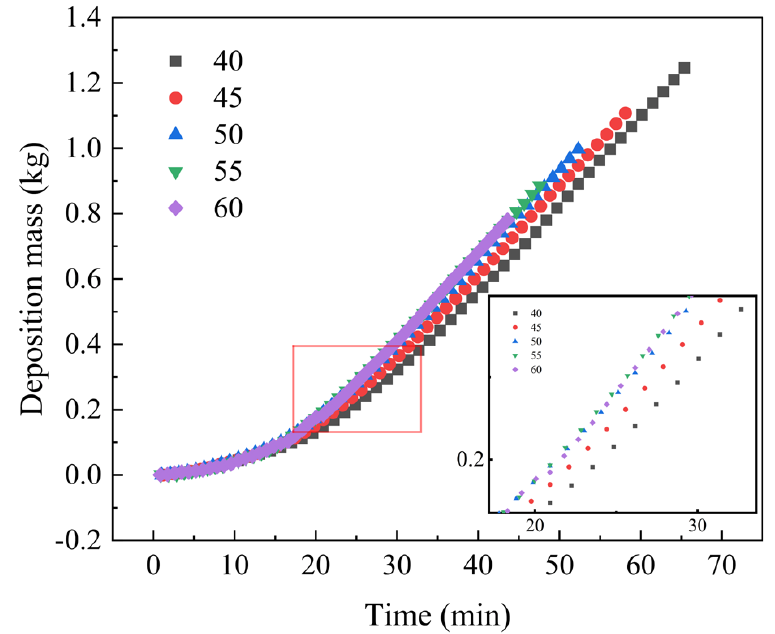
Figure 4. The relationship between deposition mass and time for different n cr .